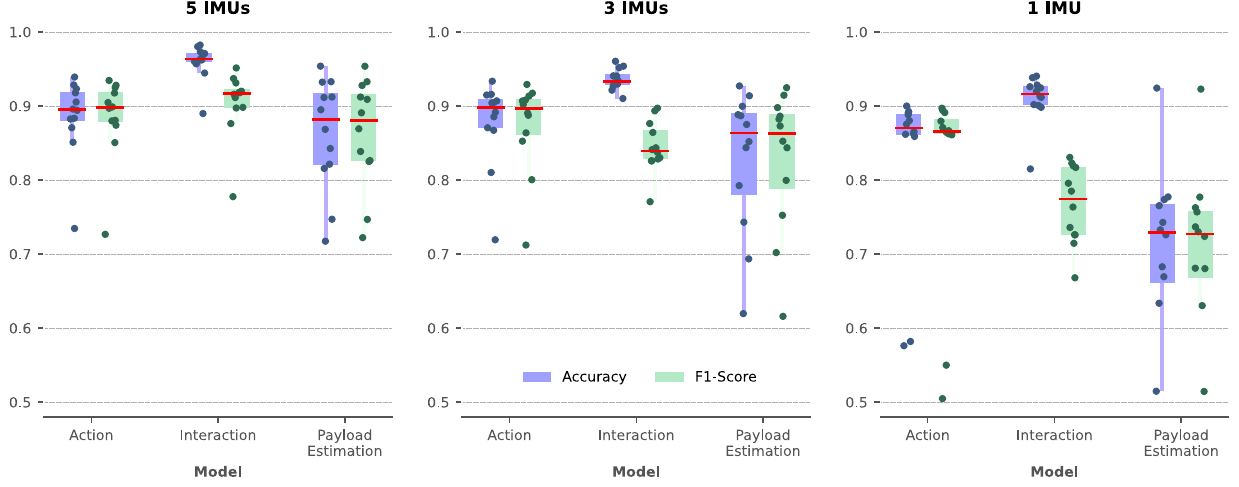
Figure 4. Boxplot-like plot of accuracy (blue) and F1-score (green) showing median value (red line), individual subject scores (dots), and quantile-based ranges (colored boxes). Results are shown for full sensor configuration (left panel) and reduced configurations (middle and right